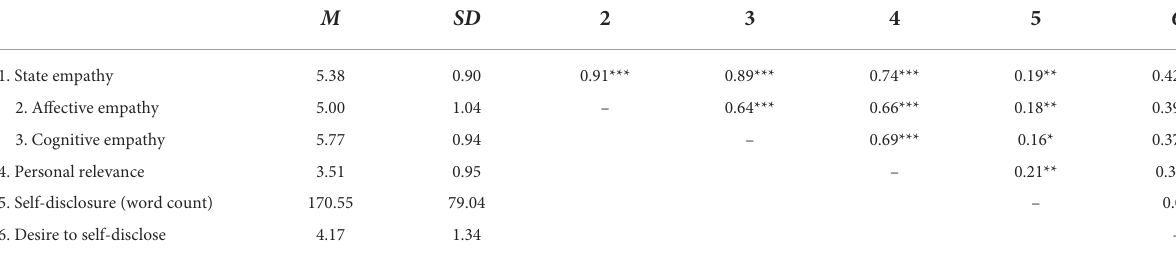
TABLE 1 Descriptives and correlations for the main study variables in Study